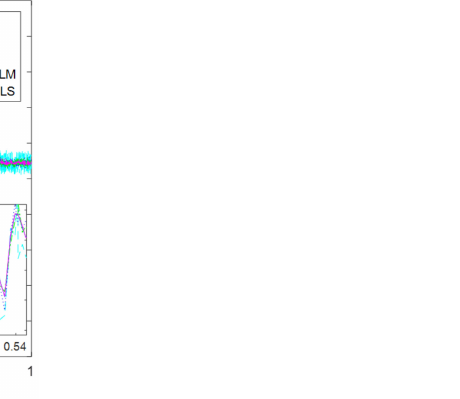
Figure 8. Power comparison of different equivalent models when the DC microgrids load is increased by 15%.